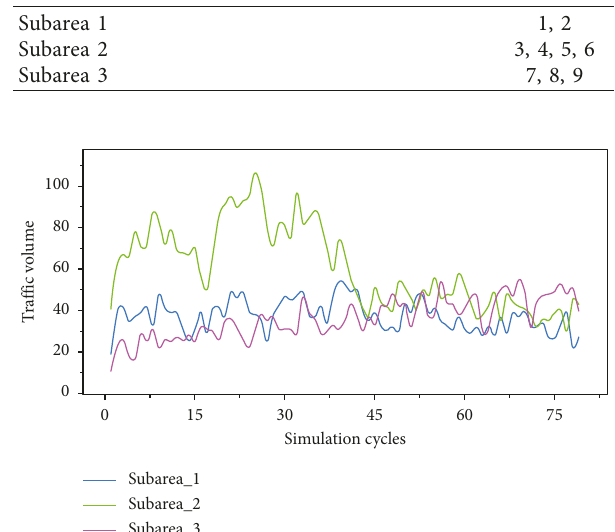
Figure 8: Evolution of traffic volume in each subarea.